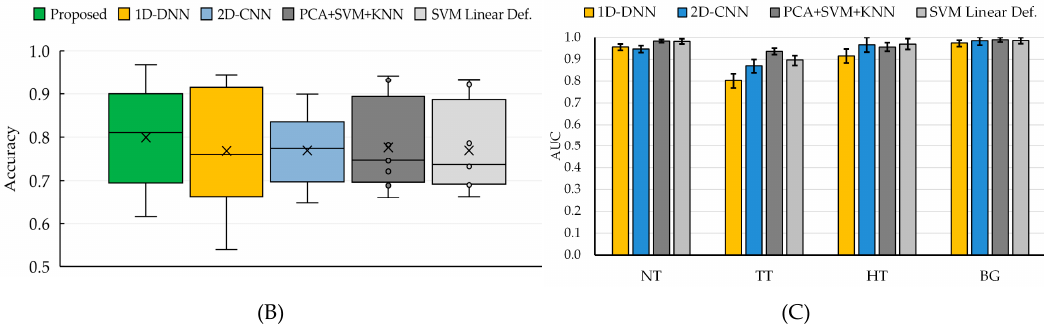
Figure 7. Average results of the leave-one-out cross-validation of the four-class dataset obtained for each classification approach using the class-balancing and bootstrapping method with the 95% confidence interval. ( A ) Overall accuracy and accuracy per class results. ( B ) Boxplot of the overall accuracy results. ( C ) Area under the curve (AUC) results per class. [NT] Normal tissue; [TT] Tumor tissue; [HT] Hypervascularized tissue; [BG] Background.